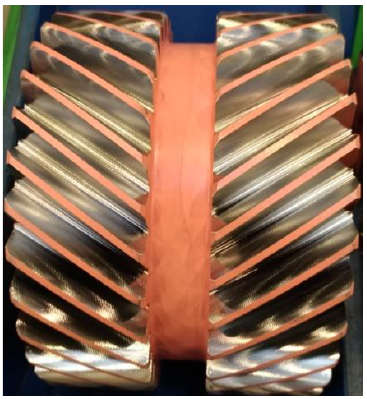
Figure 2. Double helical gear after power skiving machining.